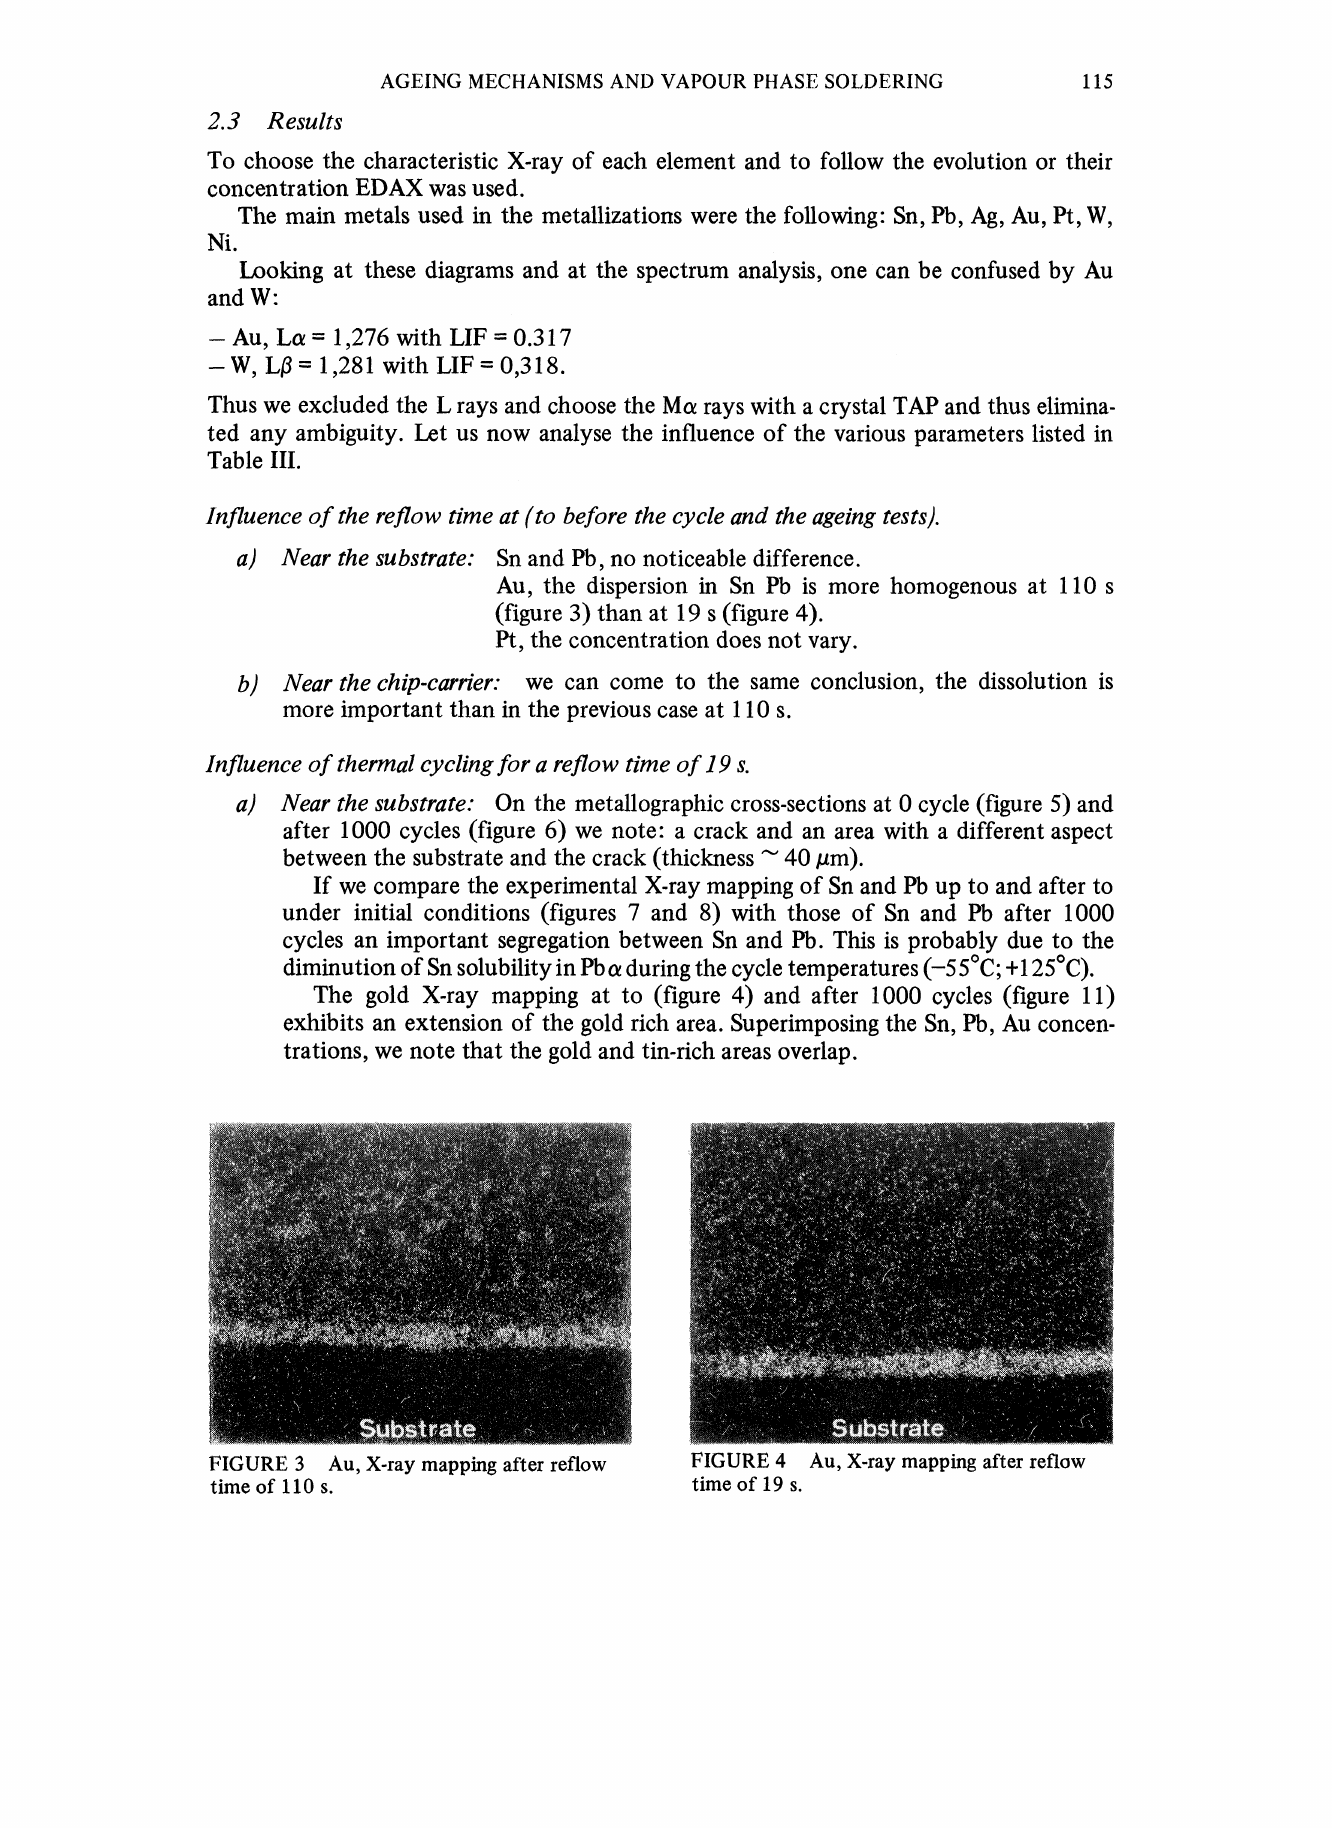
FIGURE 4 Au, X-ray mapping after reflow time of 19